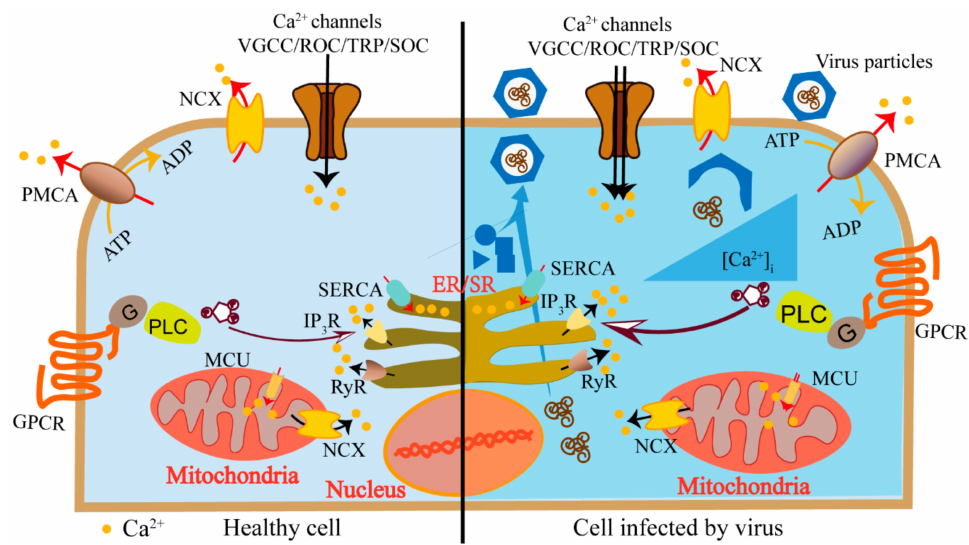
Figure 1. Schematics of host cell elevated cytosolic calcium concentration induced by a virus. Calcium channels (voltage-gated calcium channels (VGCCs), receptor-operated channels (ROC), store-operated Ca 2 + (SOC), channels and transient receptor potential (TRP) channels) mediate the entry of Ca 2 + from extracellular medium (black arrows). The IP 3 receptor (IP 3 R) and the ryanodine receptors (RyR) on the endoplasmic reticulum (ER) mediate the release of Ca 2 + from internal stores (black arrows). Calcium pumps (the plasma membrane Ca 2 + -ATPase (PMCA), sarcoplasmic / endoplasmic reticulum Ca 2 + -ATPase (SERCA)) and the Na + / Ca 2 + exchanger (NCX) are responsible for transporting Ca 2 + from the cytosol to external medium or into cellular calcium stores (red arrows). Viruses utilize these calcium components to elevate cytosolic calcium concentration to activate Ca 2 + -dependent / sensitive enzymes and transcriptional factors to promote virus replication (right